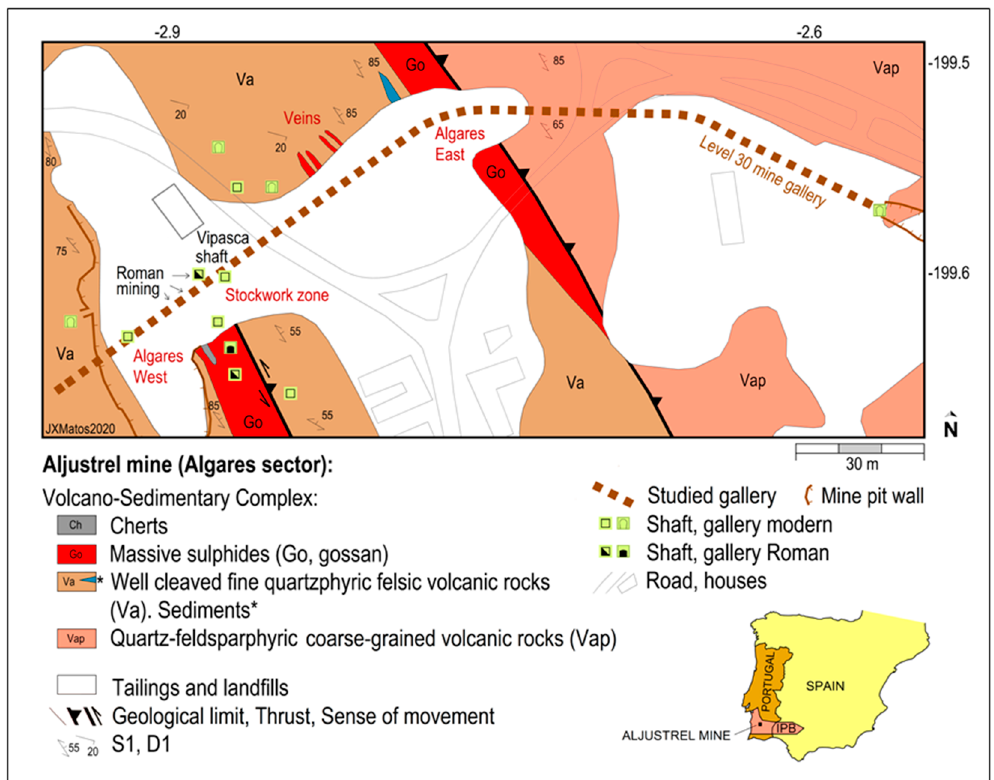
Figure 1. Geological map of the Aljustrel mine Algares NW sector. Level +30 mine gallery is projected at the surface. Minerals and crystals were collected in this gallery at Algares West and Algares East gossan orebodies and Mine Tuff volcanic unit rocks (Va) where stockwork veins occur. Old Vipasca Roman mine shafts and tunnels are visible in the studied gallery and on the surface. Coord. Hayford-Gauss Lisbon IPCC in km.